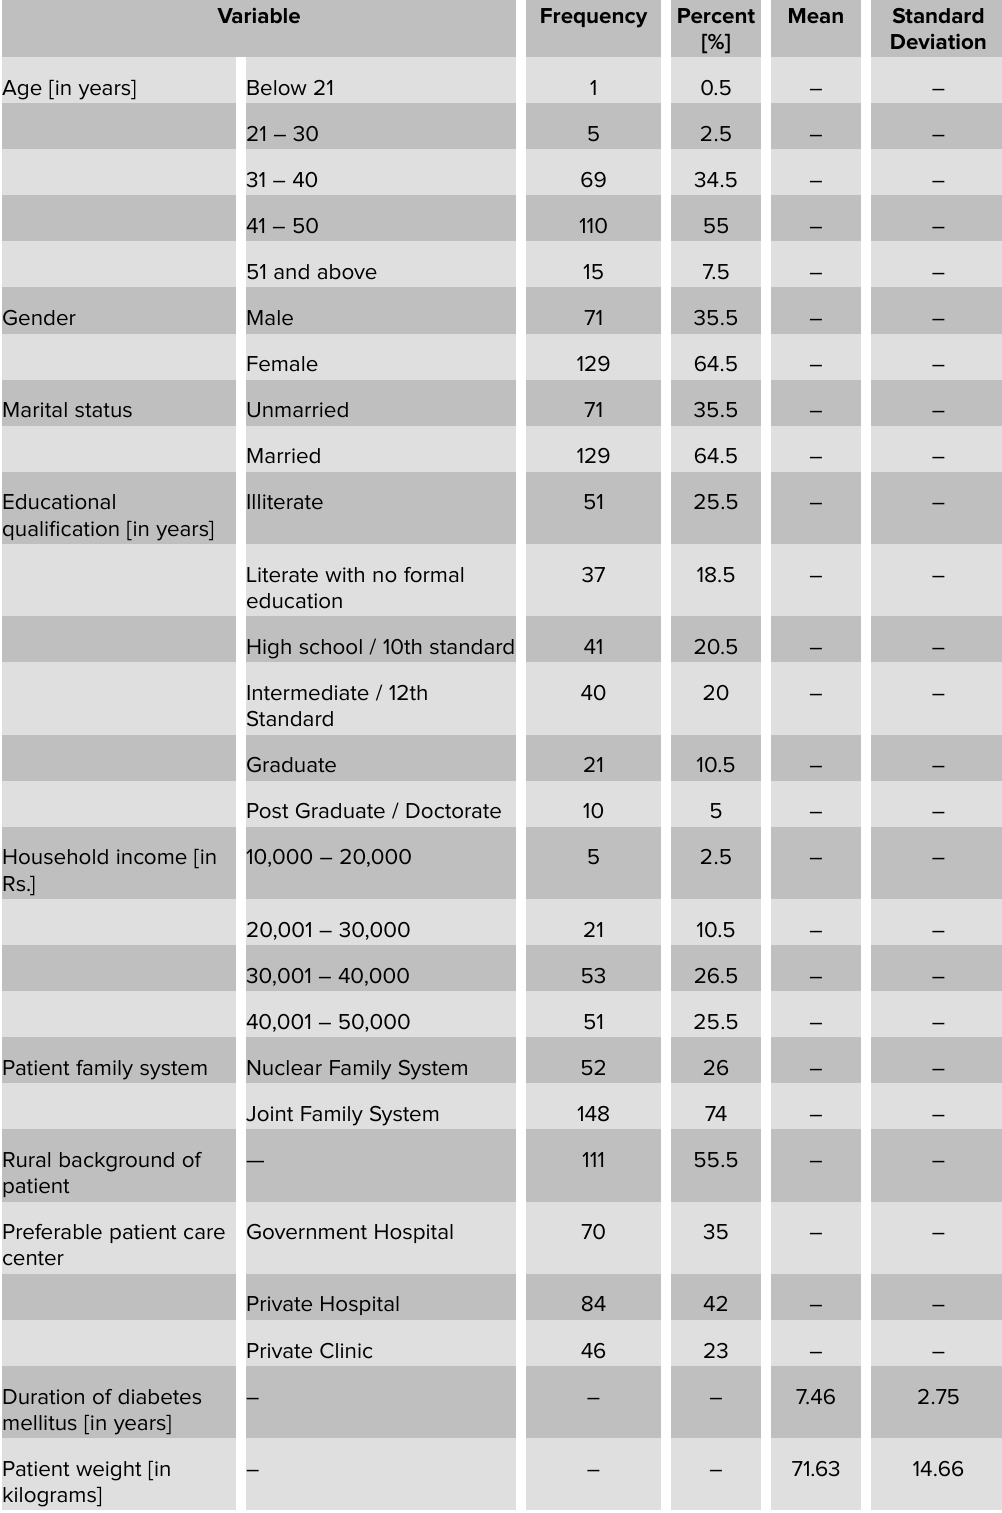
Table 1: Demographic/clinical characteristics of diabetes patients [ N =